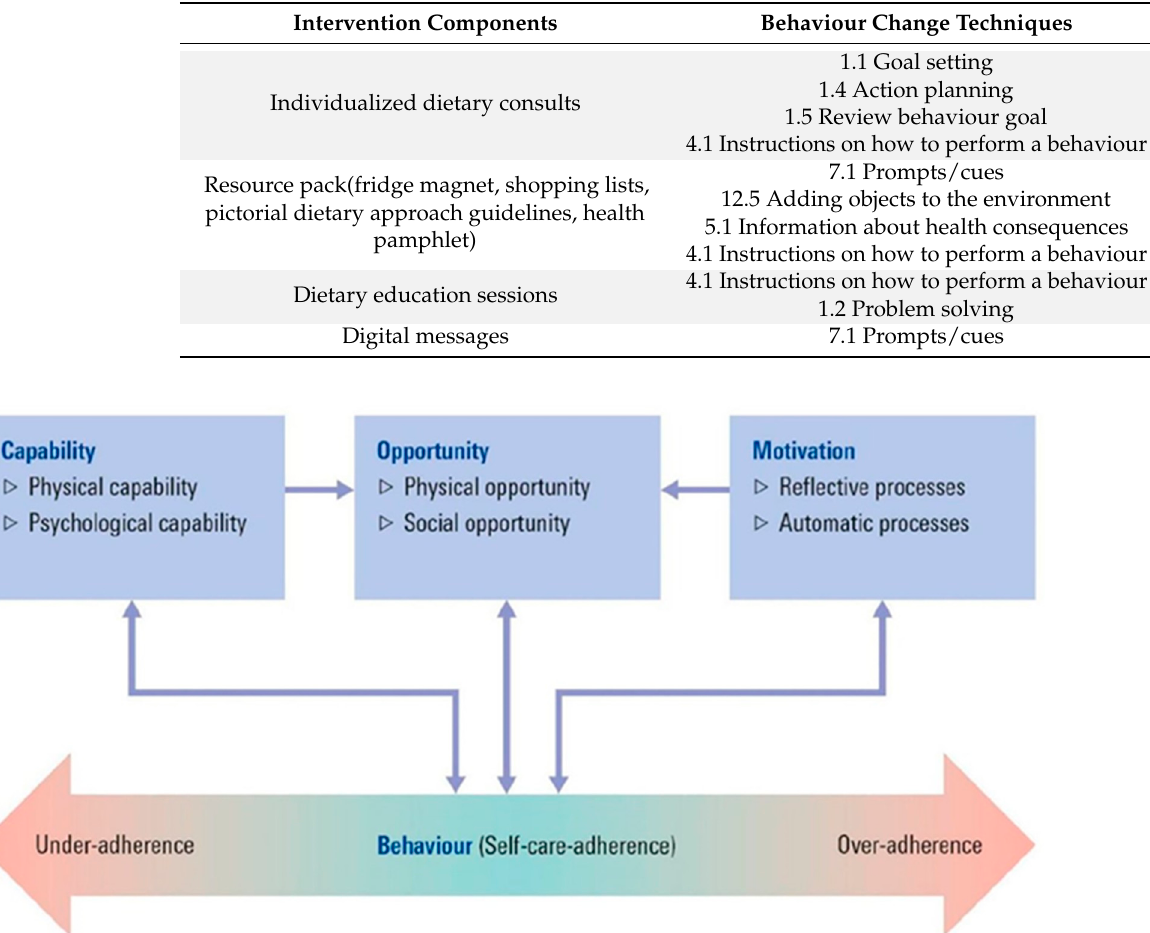
Table 3. Dietary intervention components aligned with behaviour change techniques [59].